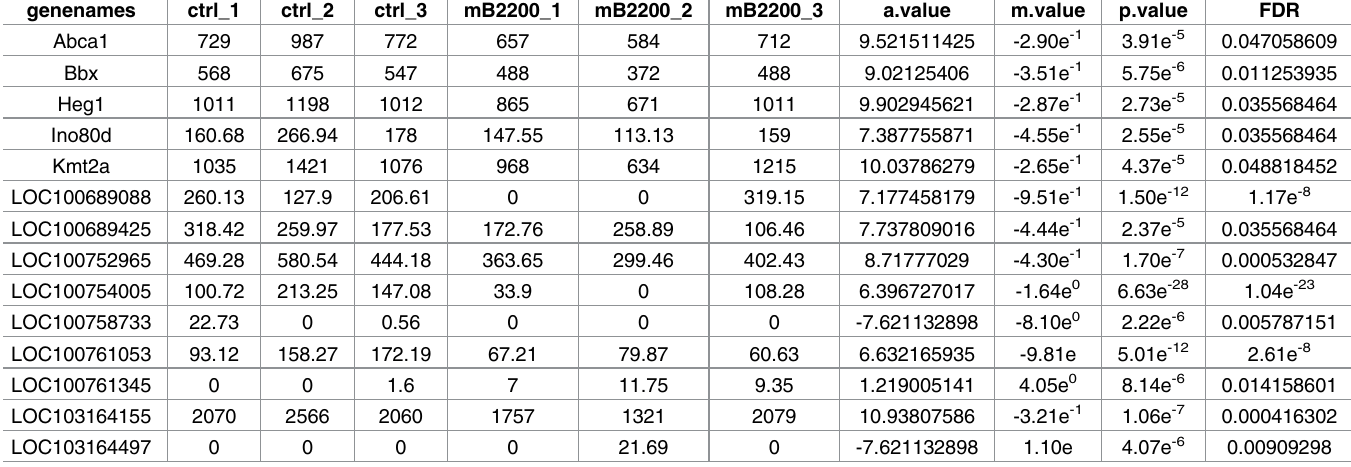
Table 2. Characterization of differentially expressedgenes in response to 0 or 22 μ M mahafacyclin